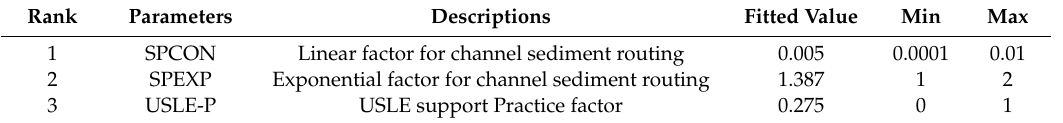
Table 6. Sensitivity analysis parameters of Sediment yield with fitted values using